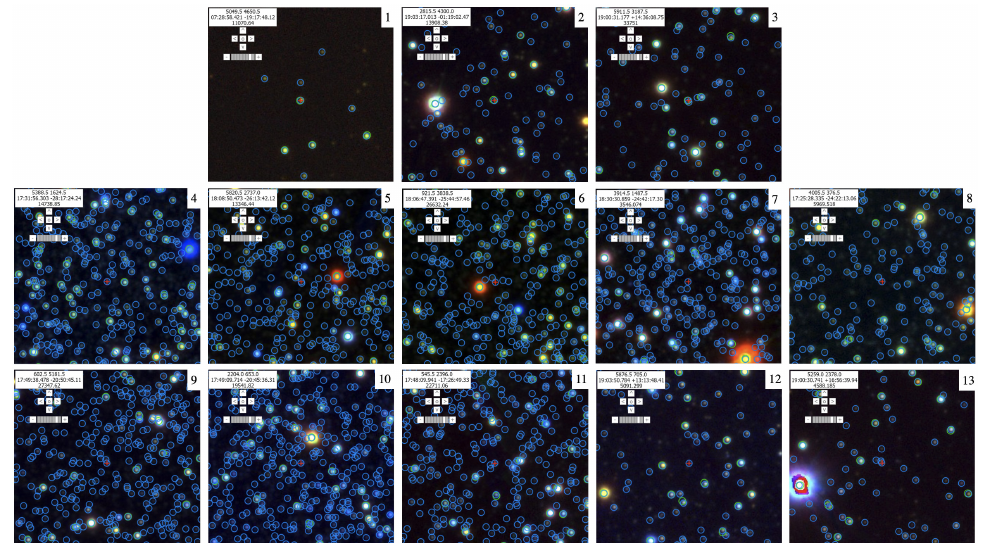
Figure 4. Pan-STARRS sky images of mirror star candidates 1–13, each marked with a red cross. Blue and green circles indicate the known position of Gaia and 2MASS catalogue objects, respectively.